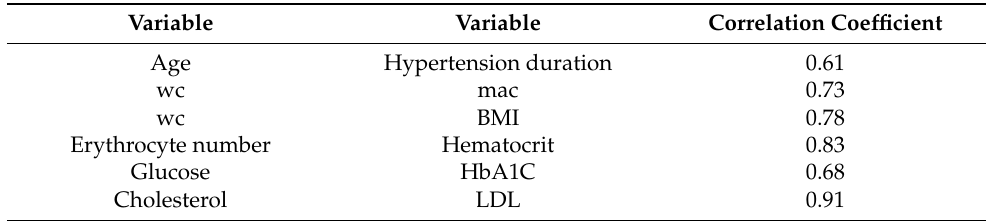
Table 2. The result of correlation